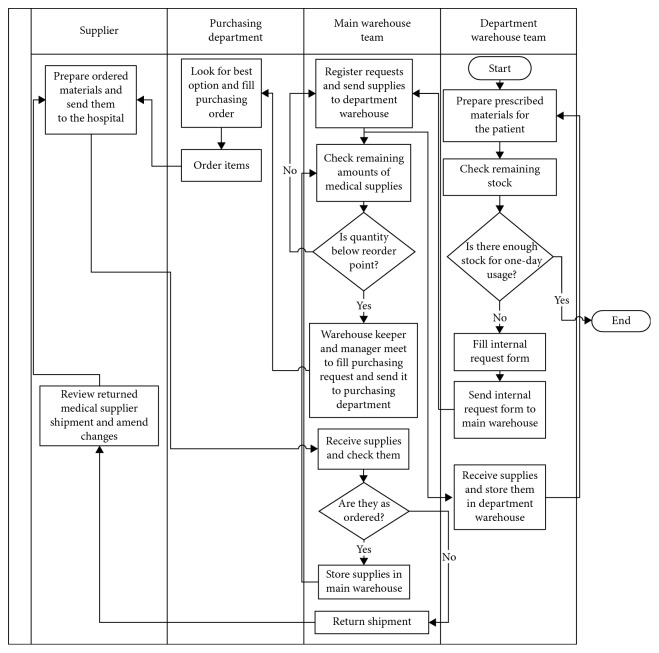
Improved process.